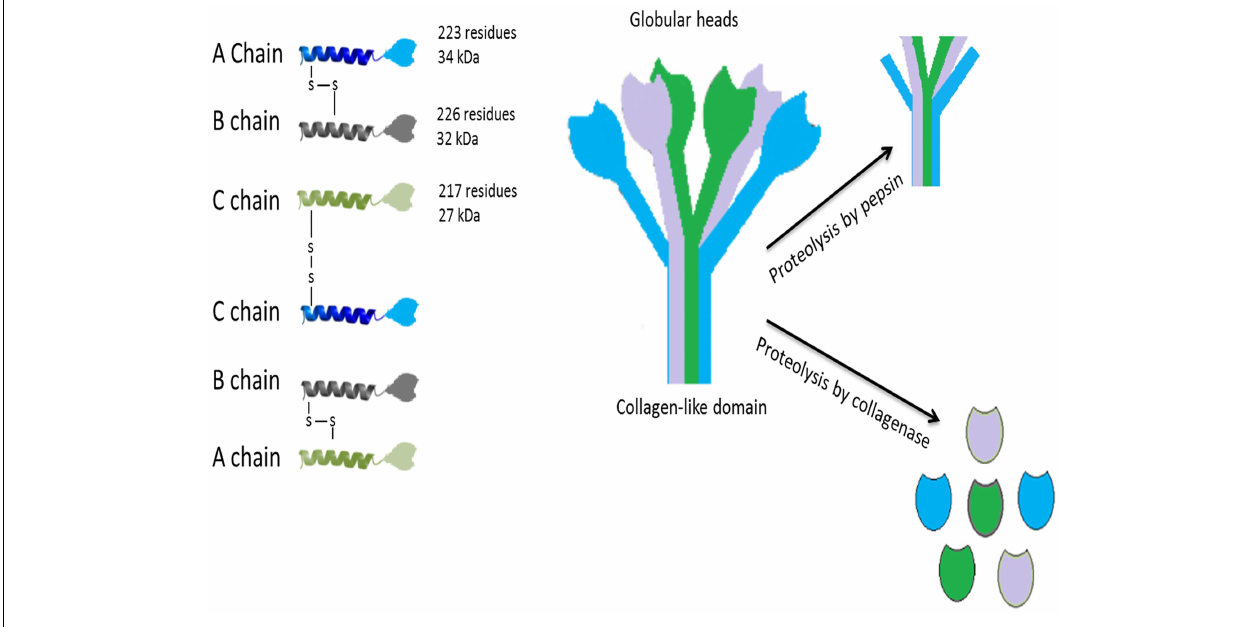
HTLV-1, C-reactive protein, damaged neurons, myelin debris, amyloid fibrils, and apoptotic cells via the gC1q domain. The collagen-like region binds to serine proteases such as C1r and C1s leading to activation of the classical pathway. Collagen region of C1q also binds to C1q receptors (most notably, cC1qR or calreticulin using CD91 as a cell-surface adaptor) to augment phagocytosis by phagocytic cells and mount a pro-inflammatory immune